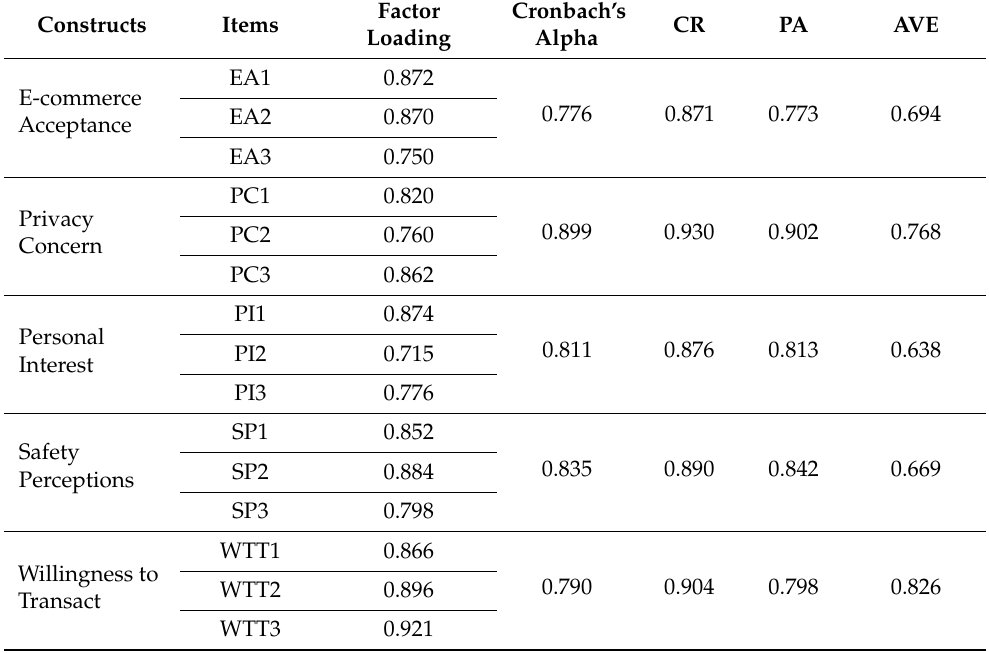
Table 3. Convergent validity results which assure acceptable values (Factor loading, Cronbach’s Alpha, composite reliability, Dijkstra–Henseler’s rho ≥ 0.70, and AVE > 0.5).